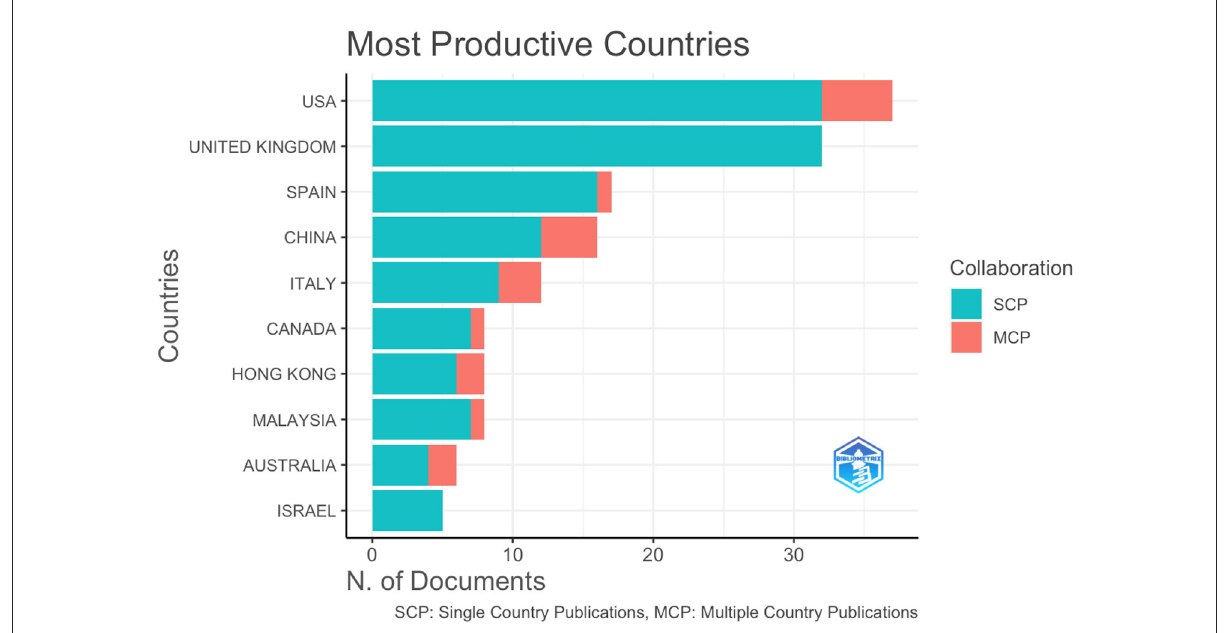
FIGURE3 The global contribution by country of corresponding author’s